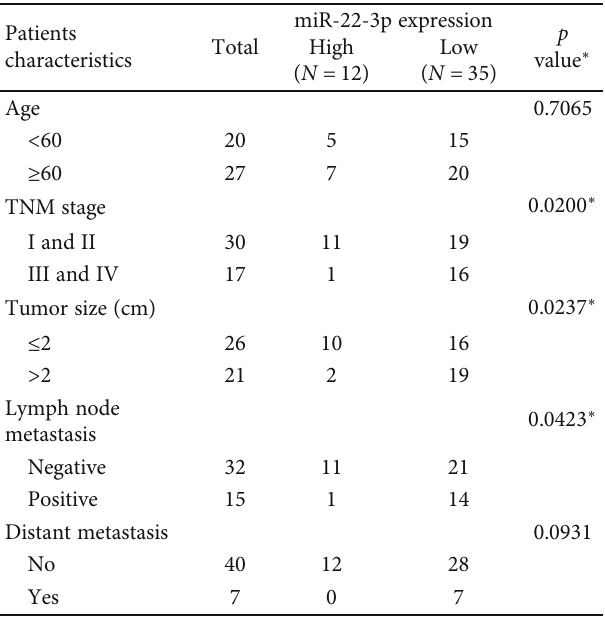
Table 1: The relationship between the expression of miR-22-3p and various clinicopathological variables. Patients